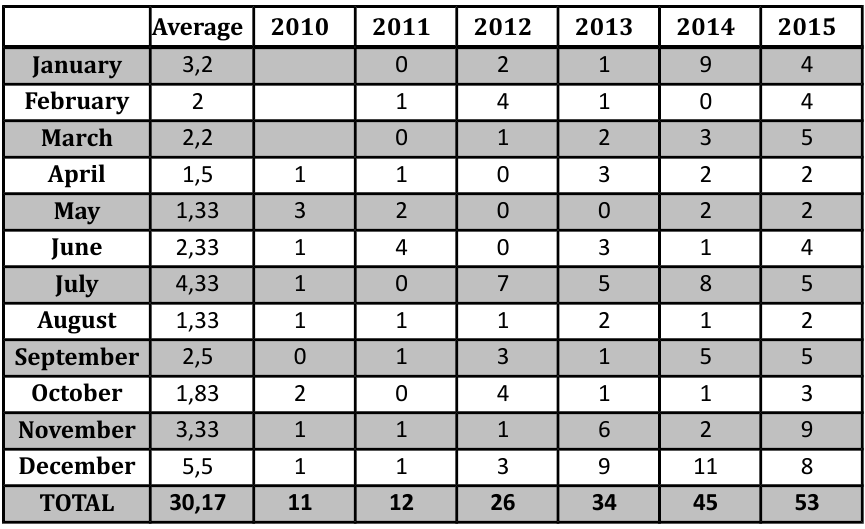
Table 1. Article submission evolution from 2010 to 2015.